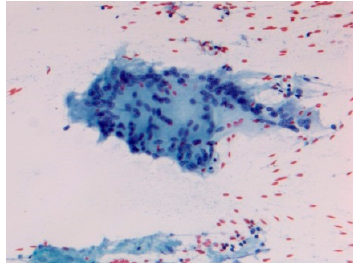
Figure 6. Acute sarcoidosis salivary gland. Cytopathology Pap stain 200×.